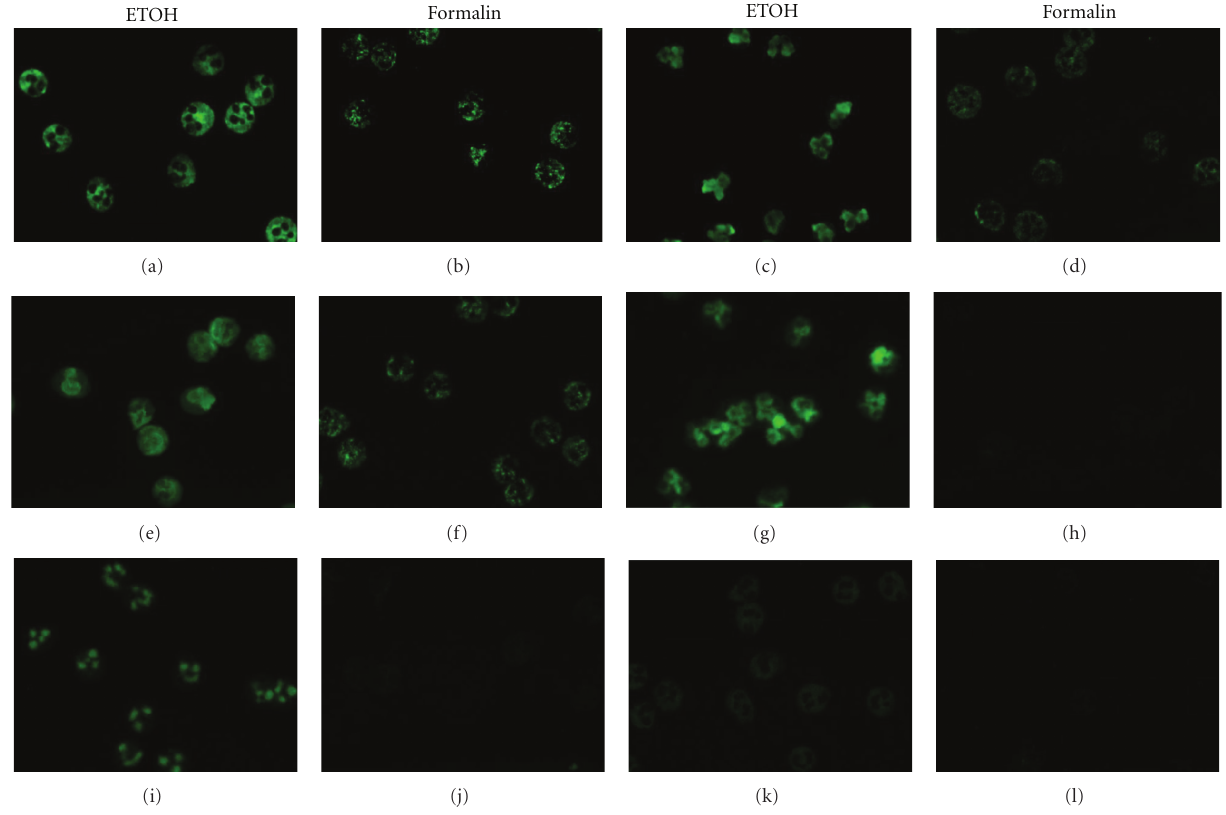
Figure 2: Images acquired by AKLIDES: typical C-ANCA on ethanol-fixed neutrophils (a) and formalin-fixed neutrophils (b); typical P-ANCA on ethanol-fixed neutrophils (c) and switch to C-ANCA on formalin-fixed neutrophils (d); expected C-ANCA revealing an atypical pattern by visual score on ethanol-fixed neutrophils and erroneously scored P-ANCA by AKLIDES (e), but consistent C-ANCA on formalin-fixed neutrophils (f); P-ANCA on ethanol-fixed neutrophils erroneously scored C-ANCA by AKLIDES (g) and consistent negative on formalin-fixed neutrophils (h); intermediate positive (1/320) homogenous ANA reported as P-ANCA on ethanol-fixed neutrophils by AKLIDES (i), being consistently negative on formalin-fixed neutrophils (j); BPI-ANCA revealing a weak C-ANCA pattern by visual score on ethanol-fixed neutrophils (k), scored negative by AKLIDES on both ethanol- and formalin-fixed neutrophils